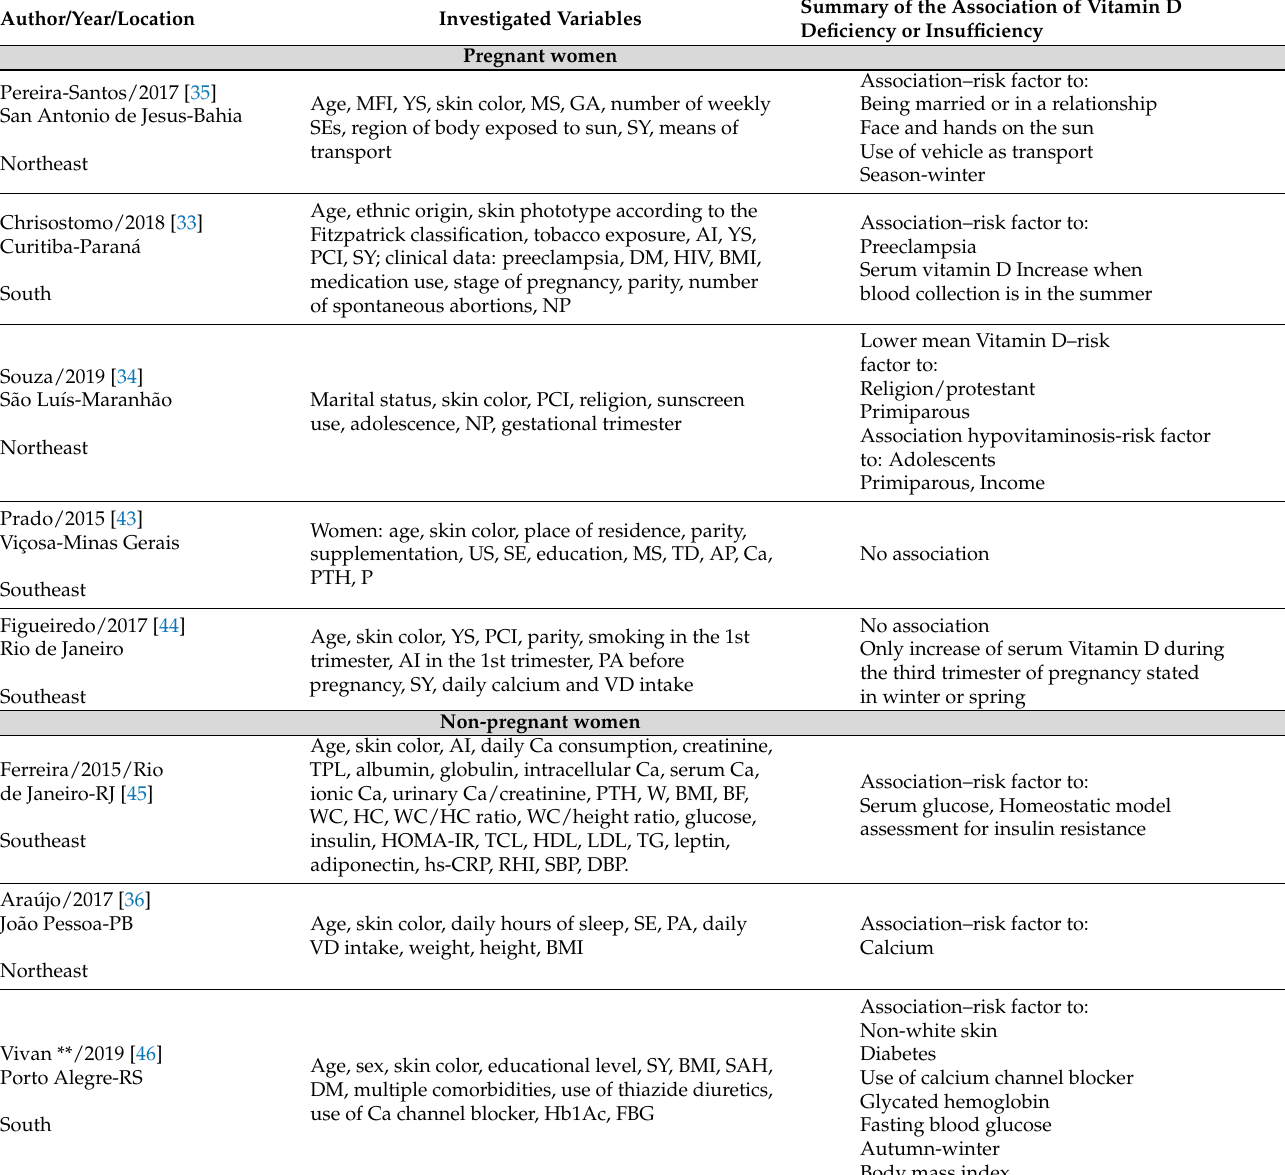
Table 1. Summarizing the association factors as risk or protective in pregnant and non-pregnant